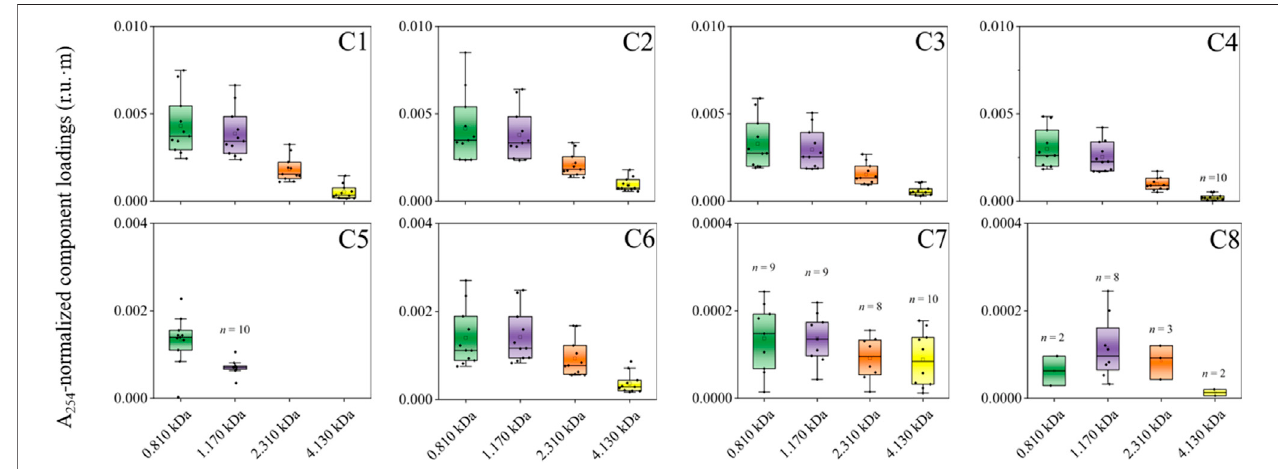
FIGURE4| A 254 -normalizedPARAFACcomponentloadings(r.u. · m)acrosssizefractions.Themarkednumber(s)withinaspeci fi ccomponentpanelindicate(s)that onlyaportionoftheentiresampleset(i.e., n =11intotal)isfoundtohavethatspeci fi ccomponentatagivensize(e.g., n =10samplesforC5at1.170 kDa).Similarly,the components without a number indicate that they are present in all samples at a given size.